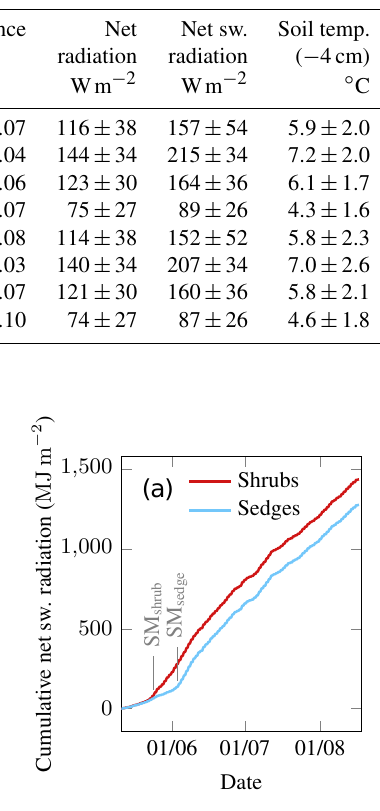
Table 2. Energy fluxes and soil temperatures (mean ± standard deviation determined from daily averages) of dwarf shrub and wet sedge vegetation under varying cloud conditions in the peak growing season 2013 and 2014; sw. denotes shortwave.